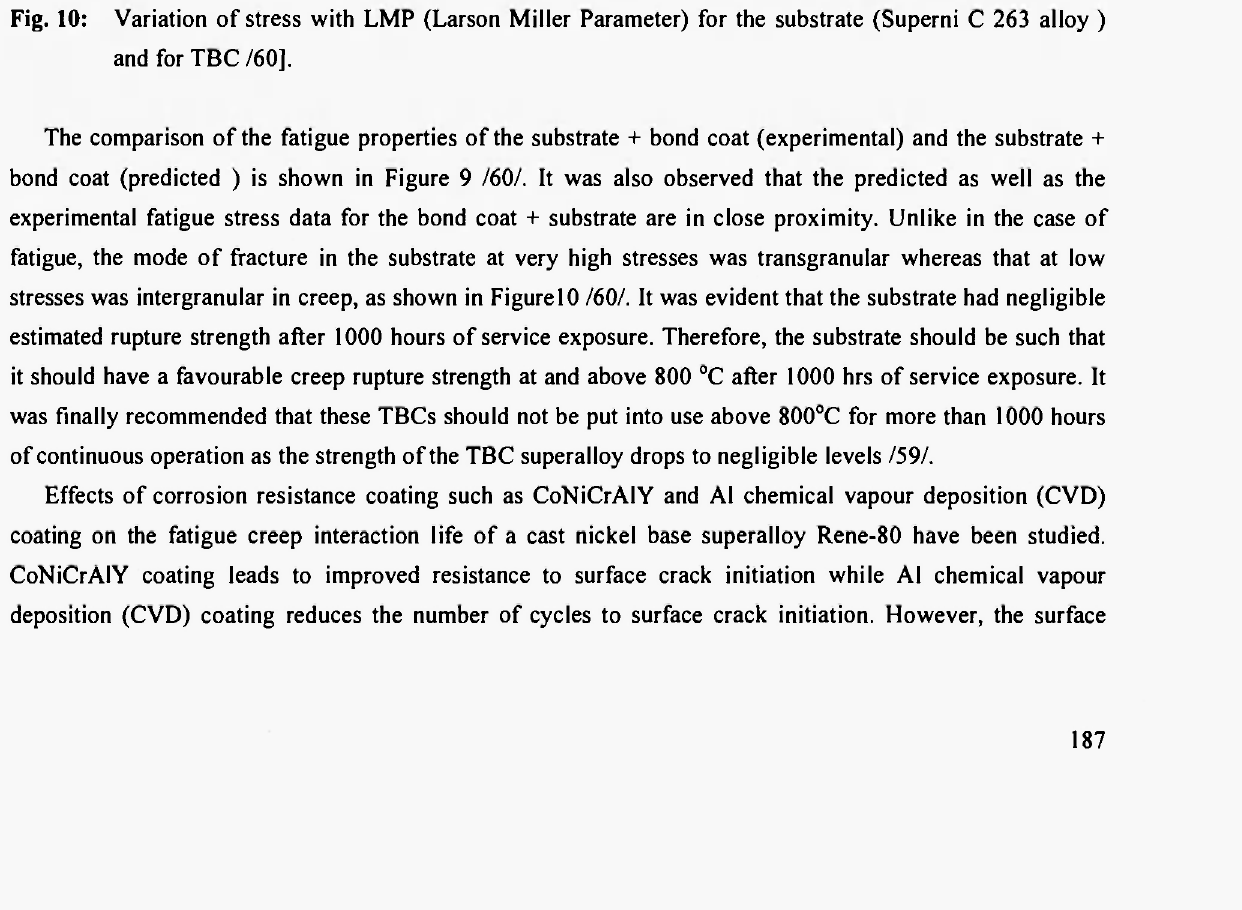
Variation of stress with LMP (Larson Miller Parameter) for the substrate (Superni C 263 alloy ) and for TBC